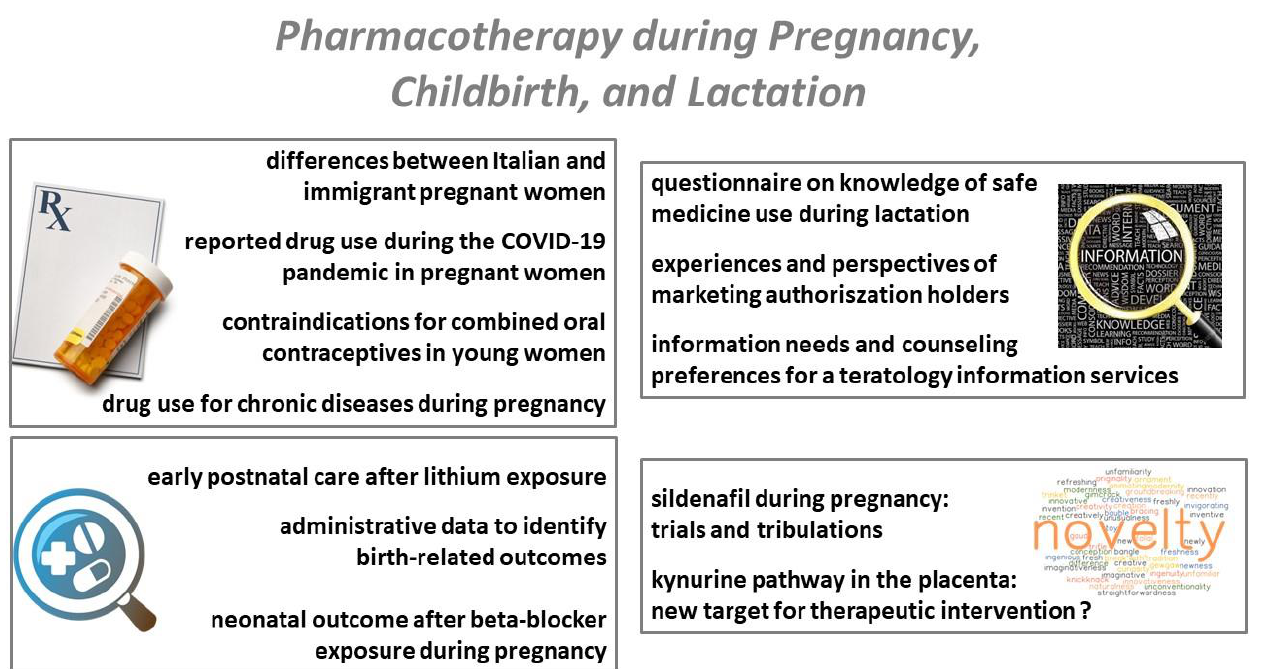
Figure 1. Overview on the different themes and specific papers discussed in this Special Issue [13 –